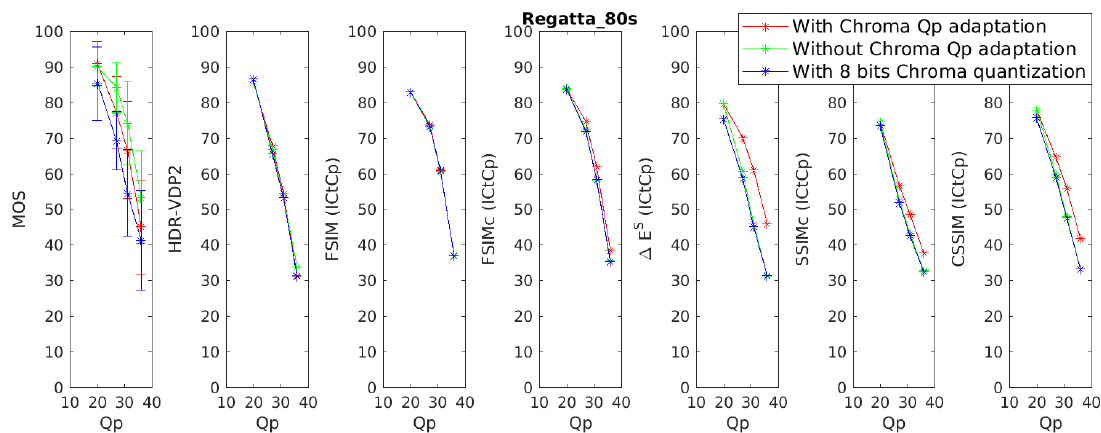
Figure A12. Subjective and objective scores for the image Regatta_80s.